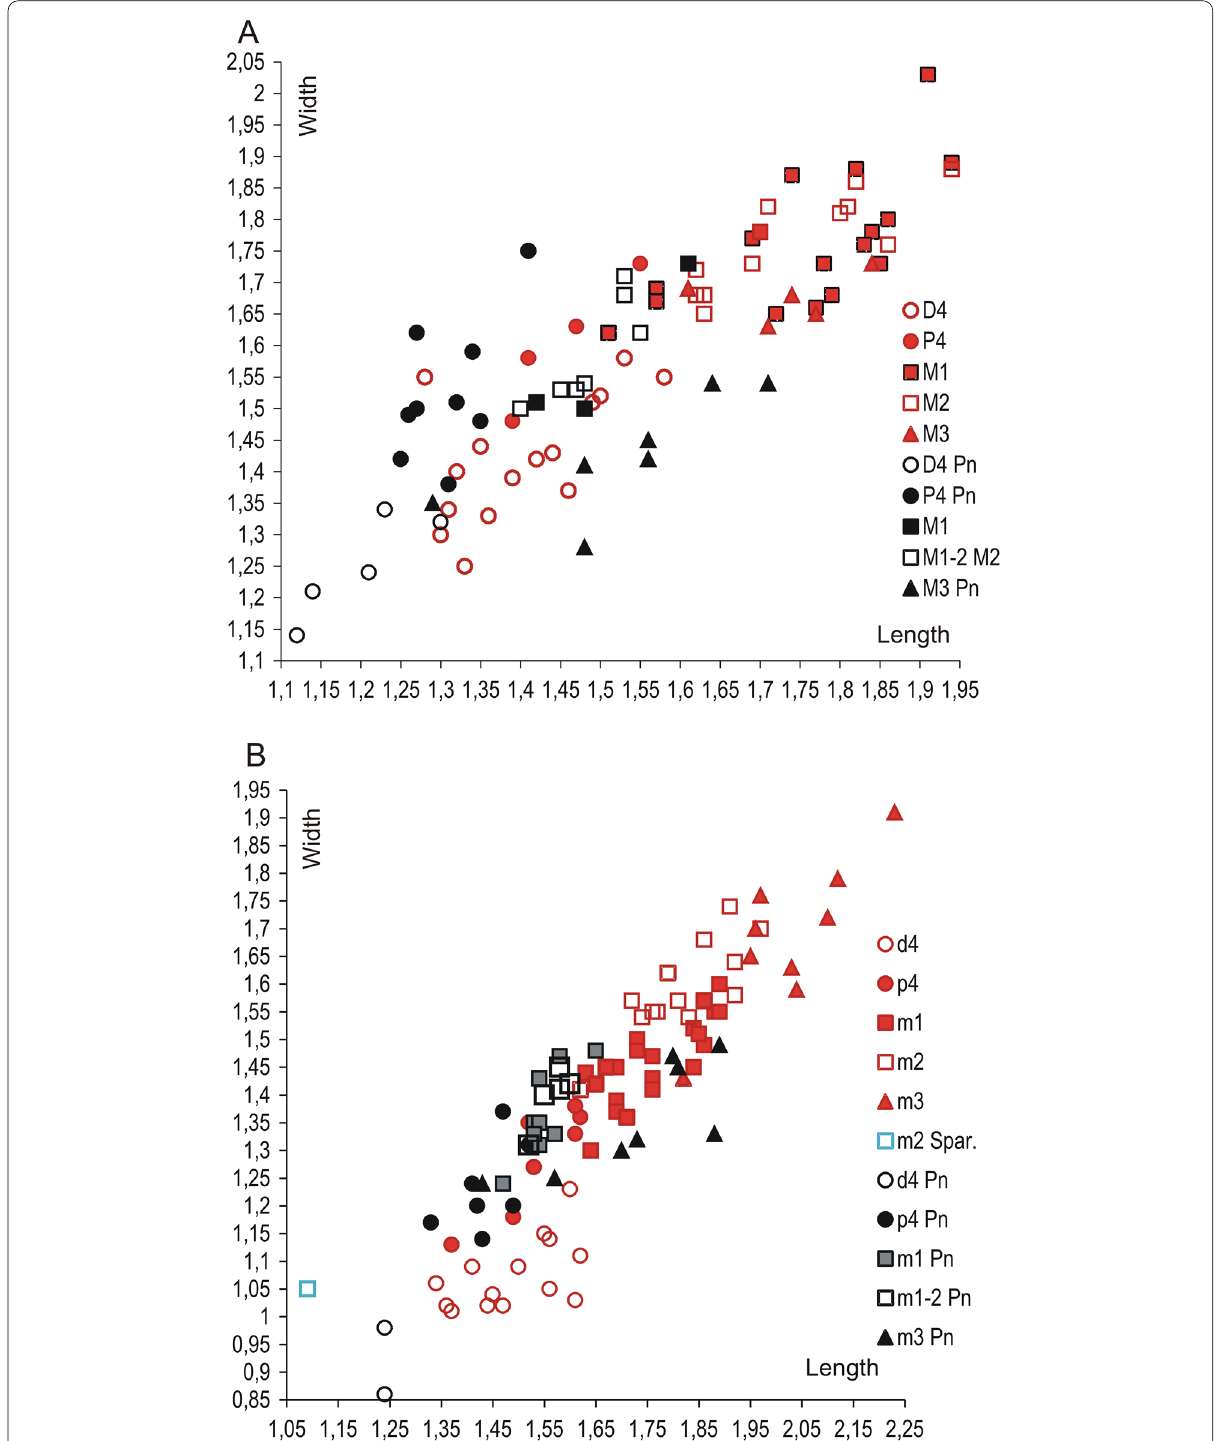
Fig. 51 Bivariate graph (width/length) of the size of the upper ( A ) and lower ( B ) teeth of ? Protadelomys nievesae Pel ǻ ez Campomanes, 1995 from Casa Ramòn (Huesca, Spain) (black marks) compared to the size of teeth of ? Protadelomys maximini Escarguel, 1998 from Saint‑Maximin (Gard) (red